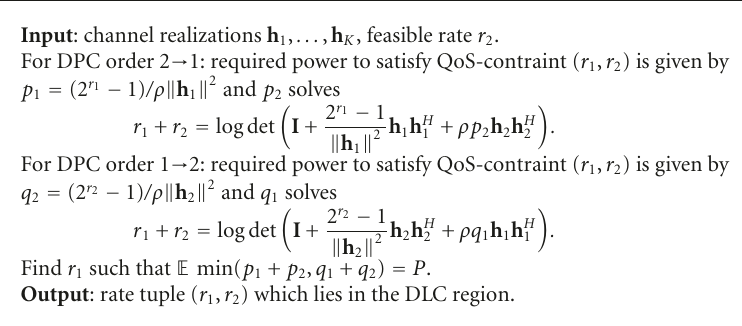
Algorithm 1: Compute the DLC region for 2-user MISO BC with perfect CSI and DPC.